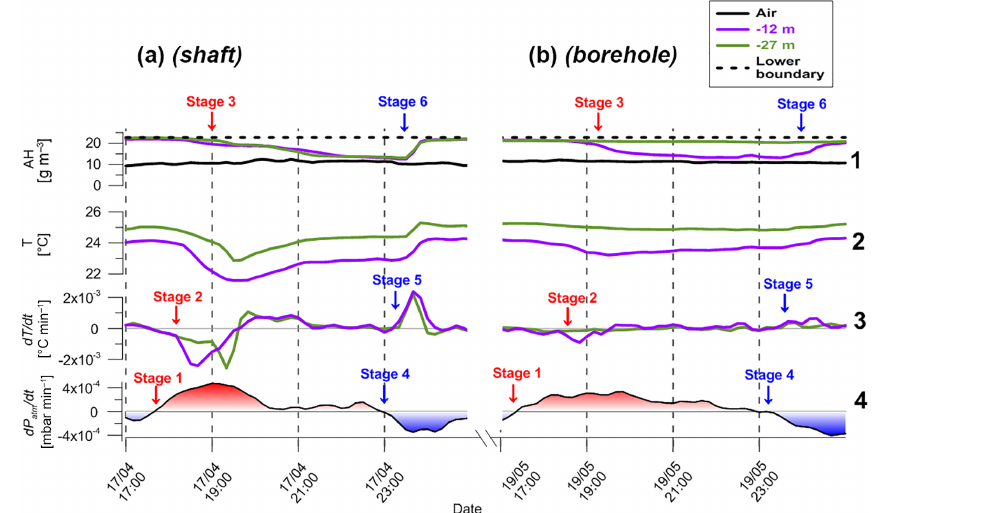
Figure 4. Time series results from a single transition event. Panels (a) and (b) represent the shaft and borehole results, respectively. The red and blue text fonts represent stages in the inflow and outflow events, respectively. d T/ d t values were derived from the temperature values in line